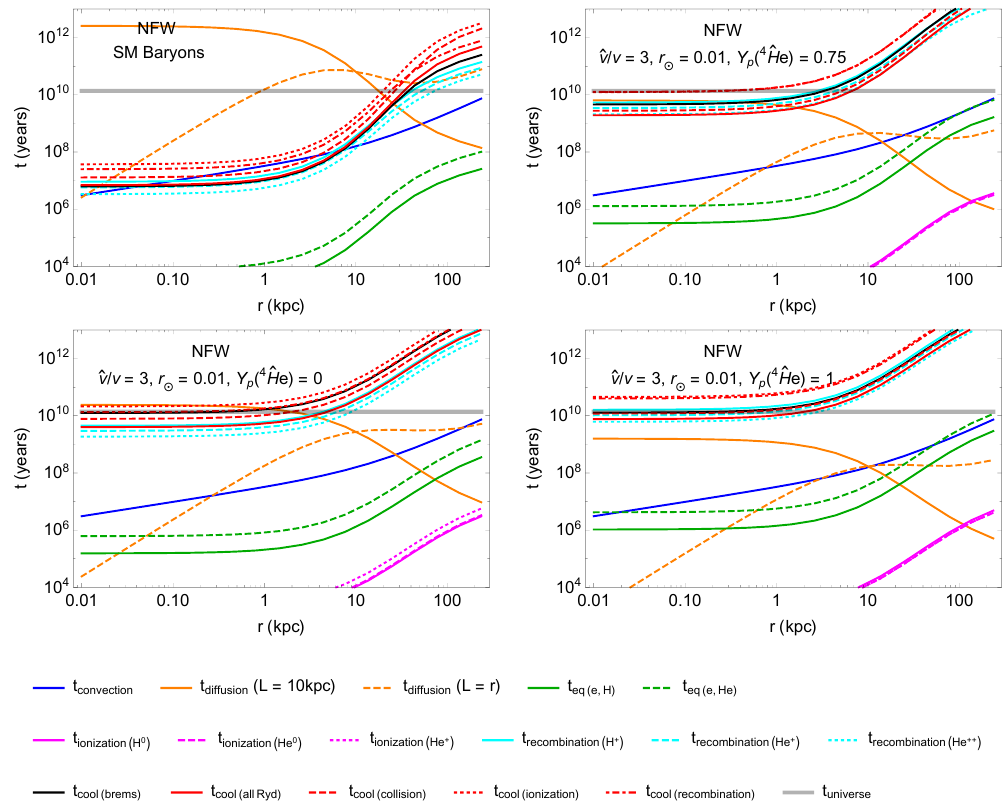
Figure 2 . Timescales in the mirror halo for equilibration between mirror electrons and atoms (green), ionization (magenta), recombination (cyan), as well as bremsstrahlung cooling (black) and collision, ionization and recombination cooling (solid red total, various dashings individual), compared to the convection timescale dictated by the CDM halo (blue) and the age of the universe (thick grey line). The diffusion timescale over two length scales ( L = r and L = 10 kpc) is also shown (orange), but this scale is not required to be small for thermal equilibrium in the already isothermal halo. The SM-like isothermal comparison halo is compared to our three MTH benchmark points from table 2 assuming an NFW CDM